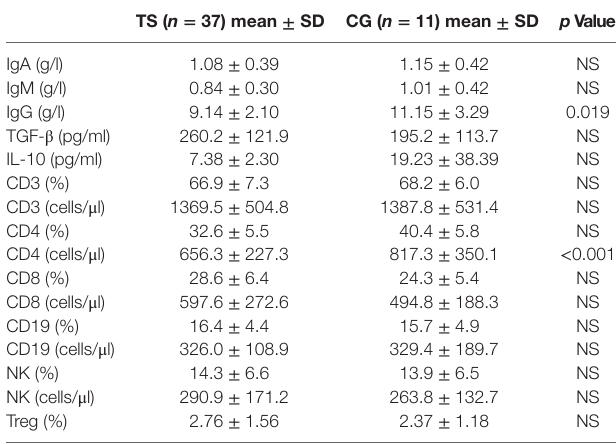
Table 2 | Laboratory markers of humoral and cellular immunity, and anti- inflammatory cytokines in girls with TS vs. healthy controls (mean ±